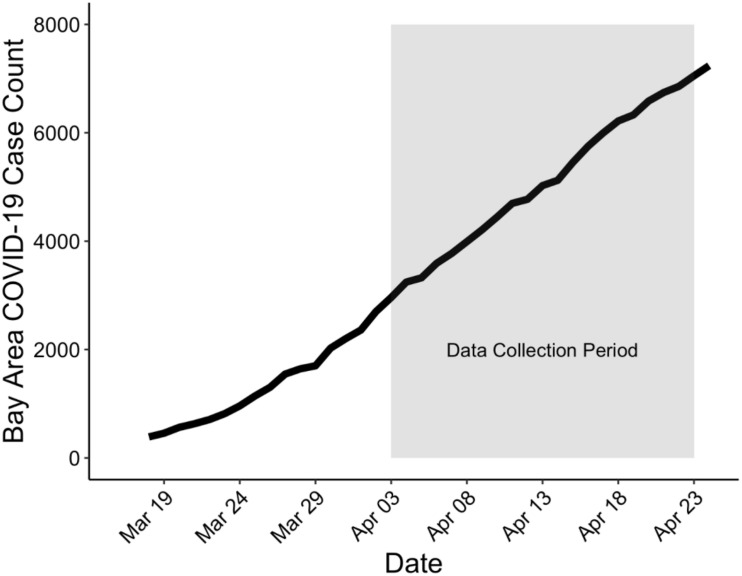
Timeline of data collection in the current study (highlighted in gray) relative to rising cases in the San Francisco Bay Area. Shelter-in-place was issued between March 16–18, 2020. The first participant completed the survey April 3rd, 2020 and the last participant completed the survey April 23rd, 2020. COVID-19 cases were taken from https://data.ca.gov/
dataset/covid-19-cases from the following counties: Alameda, Contra Costa, Marin, Napa, San Francisco, San Mateo, Santa Clara, Solano, and Sonoma.